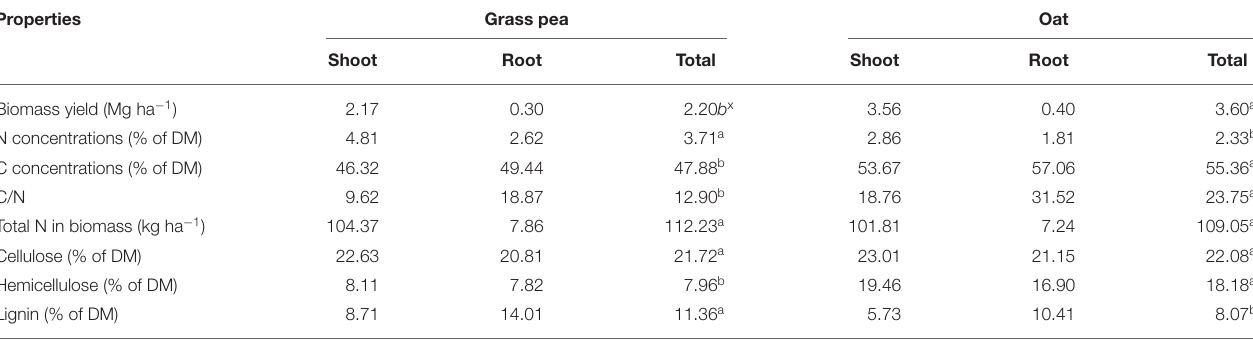
TABLE 1 | Average ( n = 3) yield and chemical composition of grass pea and oat grown as green N crops. Properties Grass